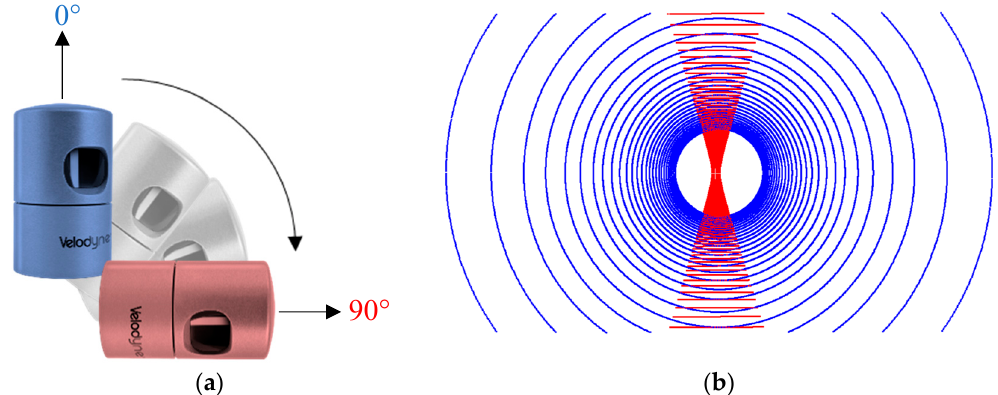
Figure 4. ( a ) Lidar tilt angles illustration. ( b ) Patterns of the Lidar beams at 0 ° (blue) and 90 ° (red) angles on a road surface from a top view.